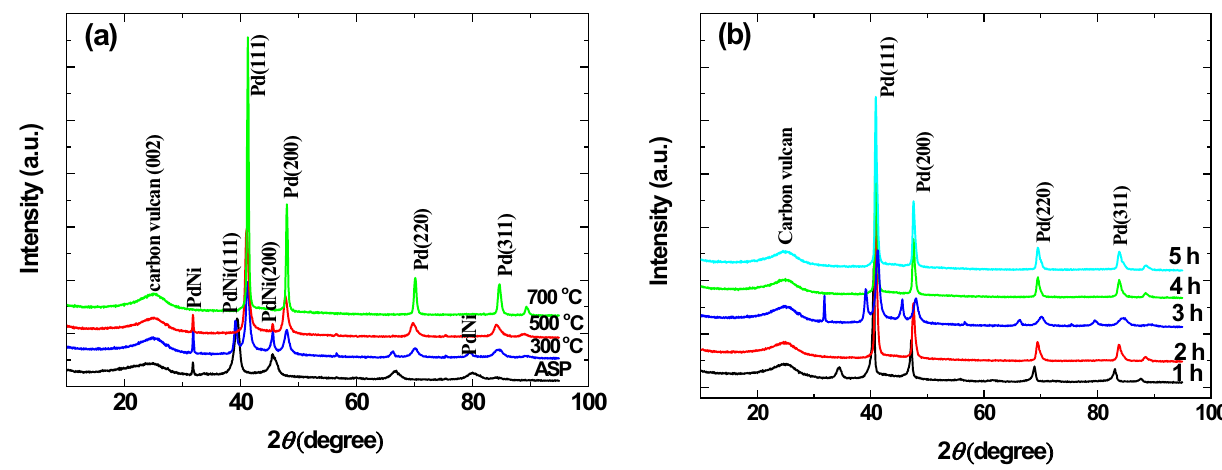
Fig. 1 XRD patterns of the carbon-supported PdNi calcined, a at different temperatures and b at 300 (cid:3) C for different times